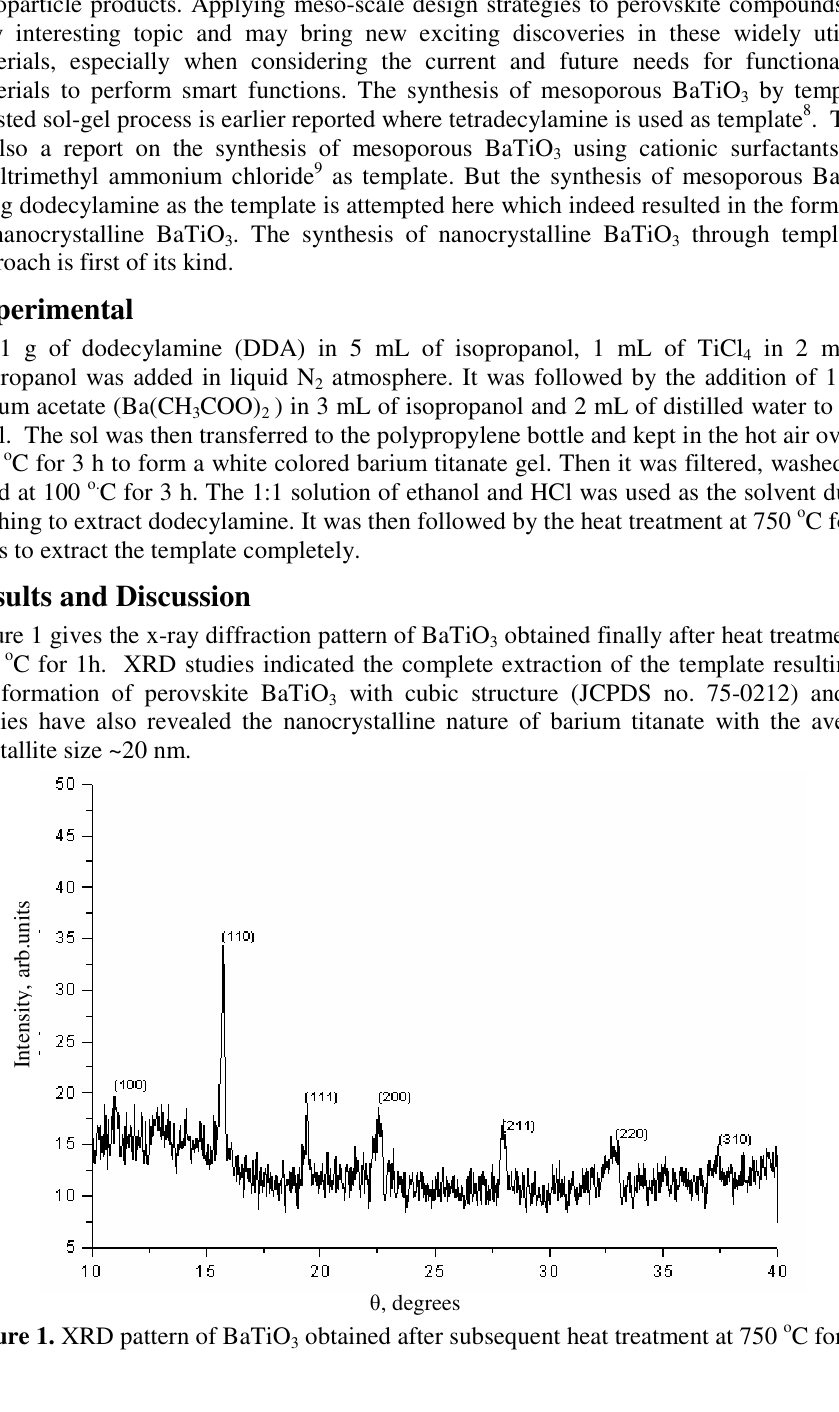
obtained after subsequent heat treatment at 750 o C for 1 3